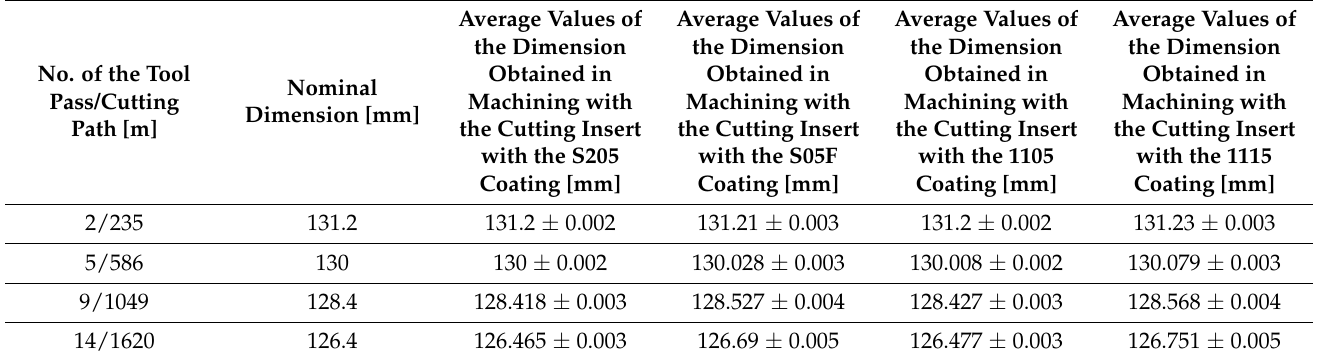
Table 1. The values of diameter dimensions obtained in the investigation.